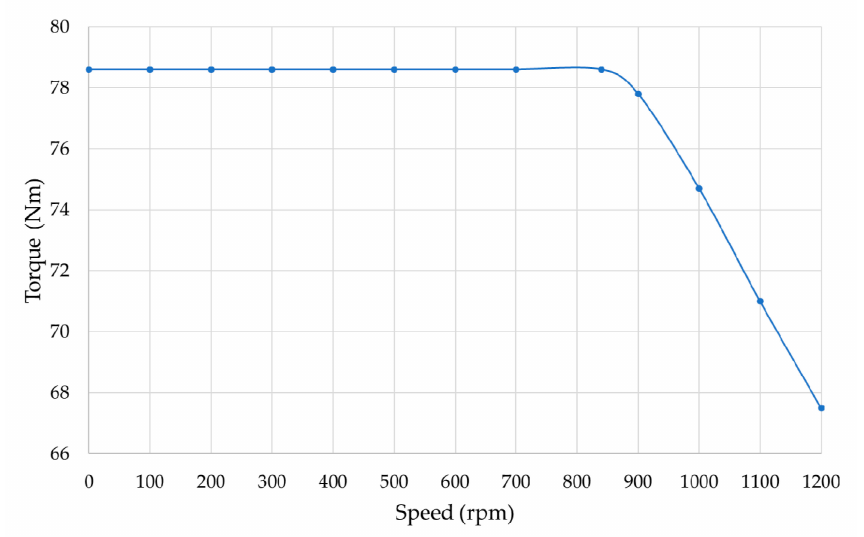
Figure 9. The Torque vs. Speed curve. Table 4. Motor losses and efficiencies at different working